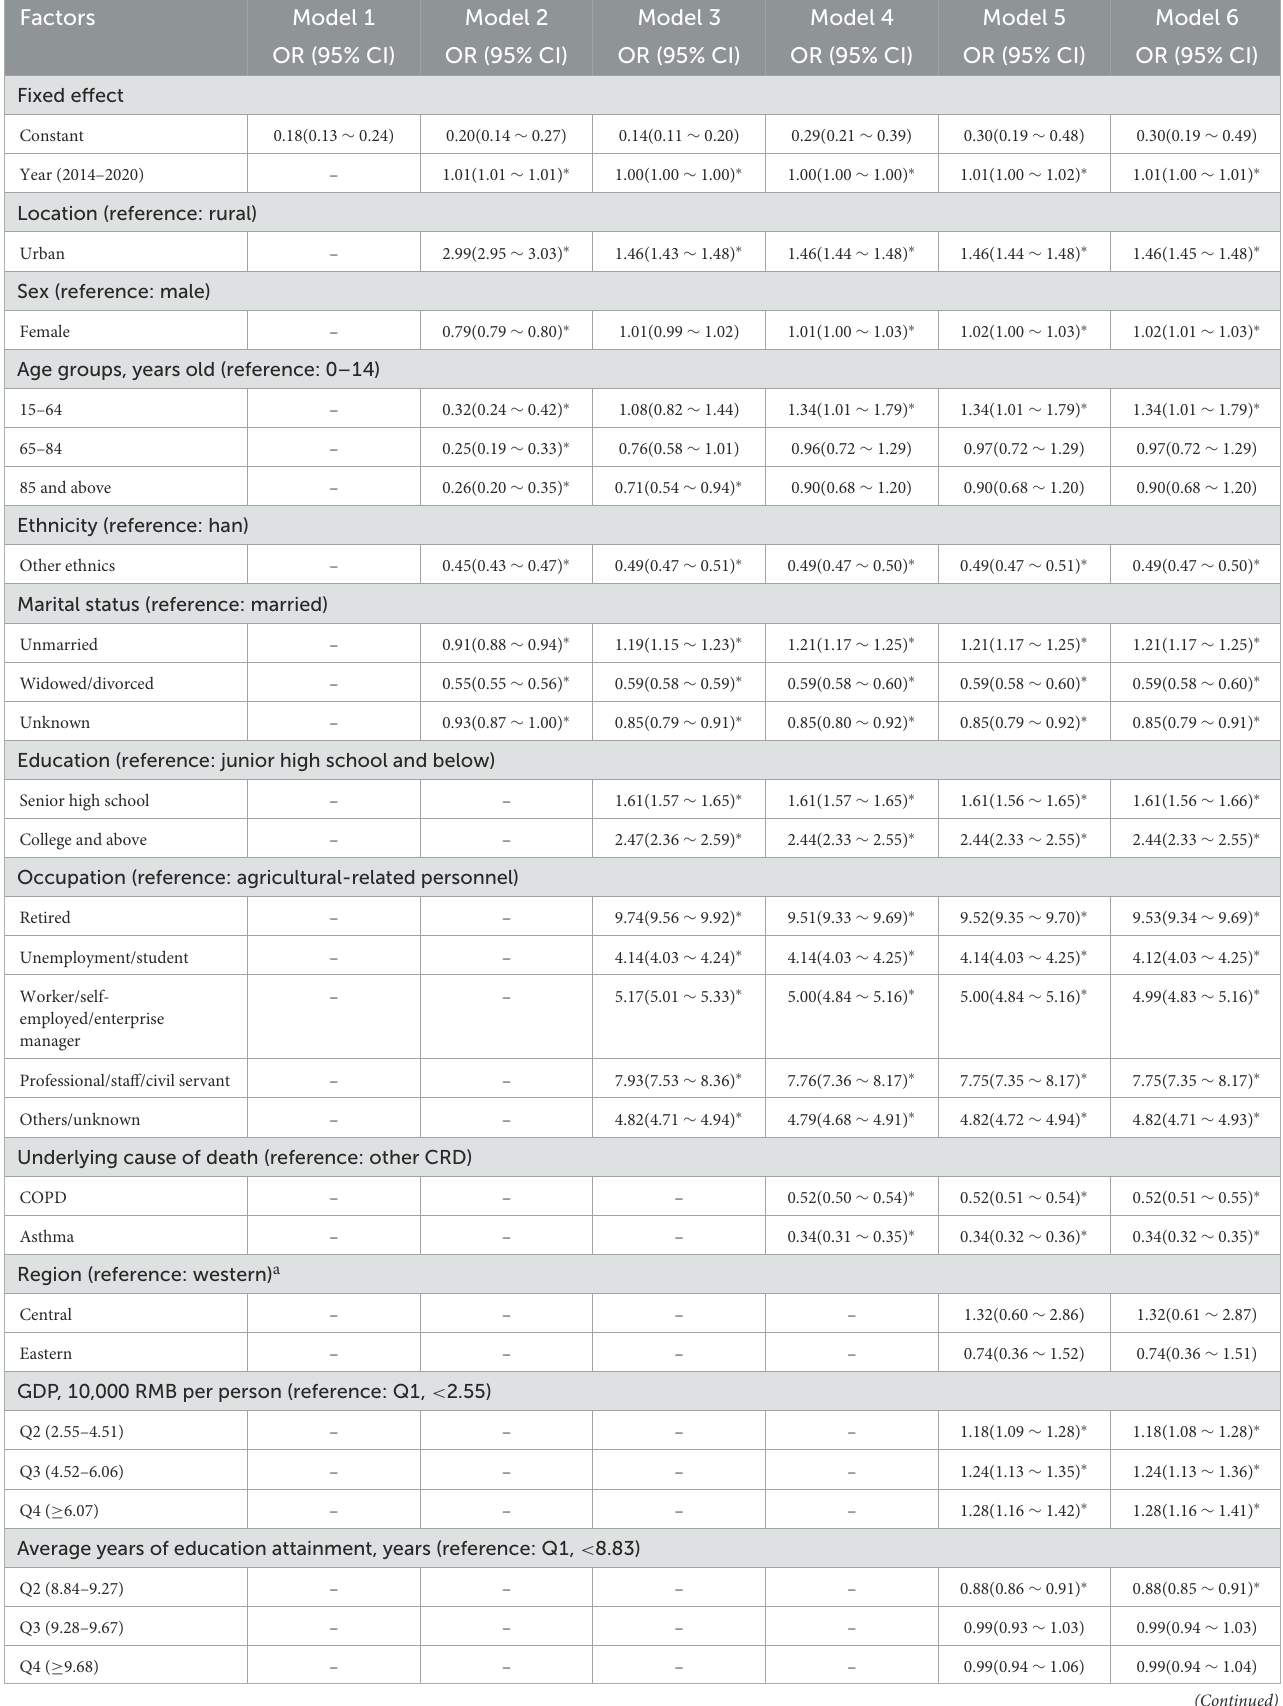
TABLE 2 Associated factors of hospital CRD deaths from the NMSS in China, 2014–2020: estimated from multilevel logistics regression.